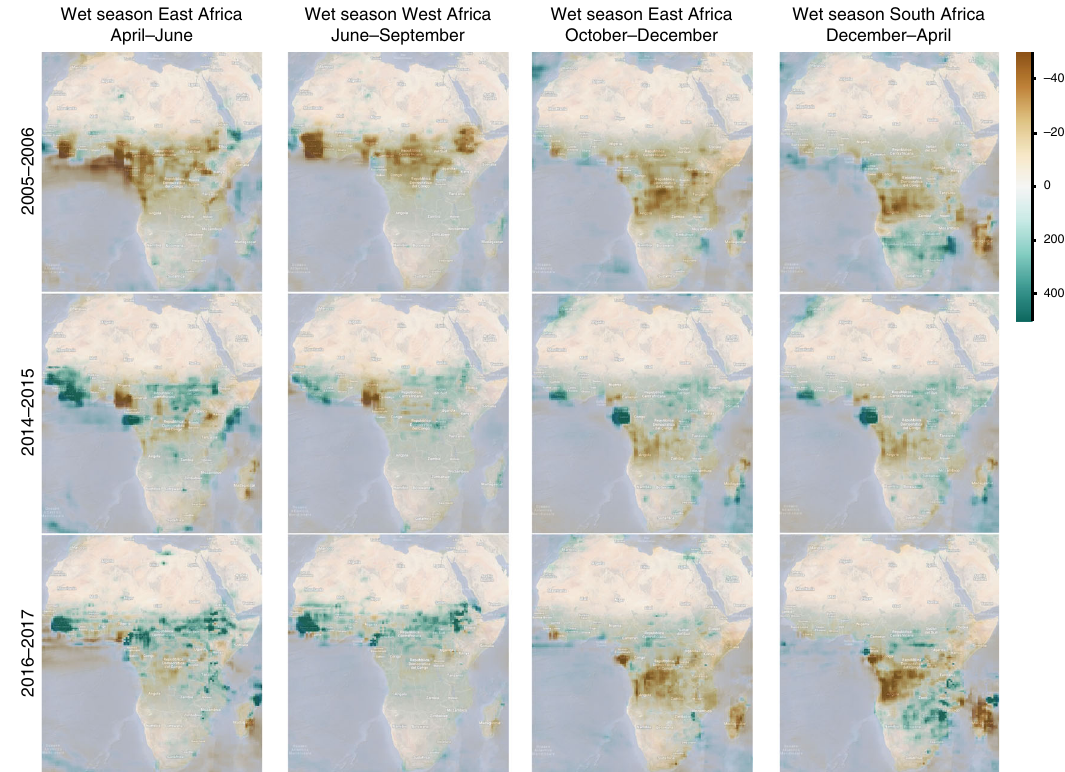
Fig. 8 Precipitation anomaly maps for the African continent. Total precipitation rates difference from the 1981 to 2018 baseline mean for the wet seasons in east Africa (April – June and October – December), West Africa (June – September) and South Africa (December – April) for years 2005 – 2006, 2014 – 2015 and 2016 – 2017. Scale bar shows the precipitation (in mm) difference from average. Maps were obtained from Climate Engine 49 available at https://app. climateengine.org. Data Source: MERRA2 ~50-km (0.5° × 0.625°) daily dataset